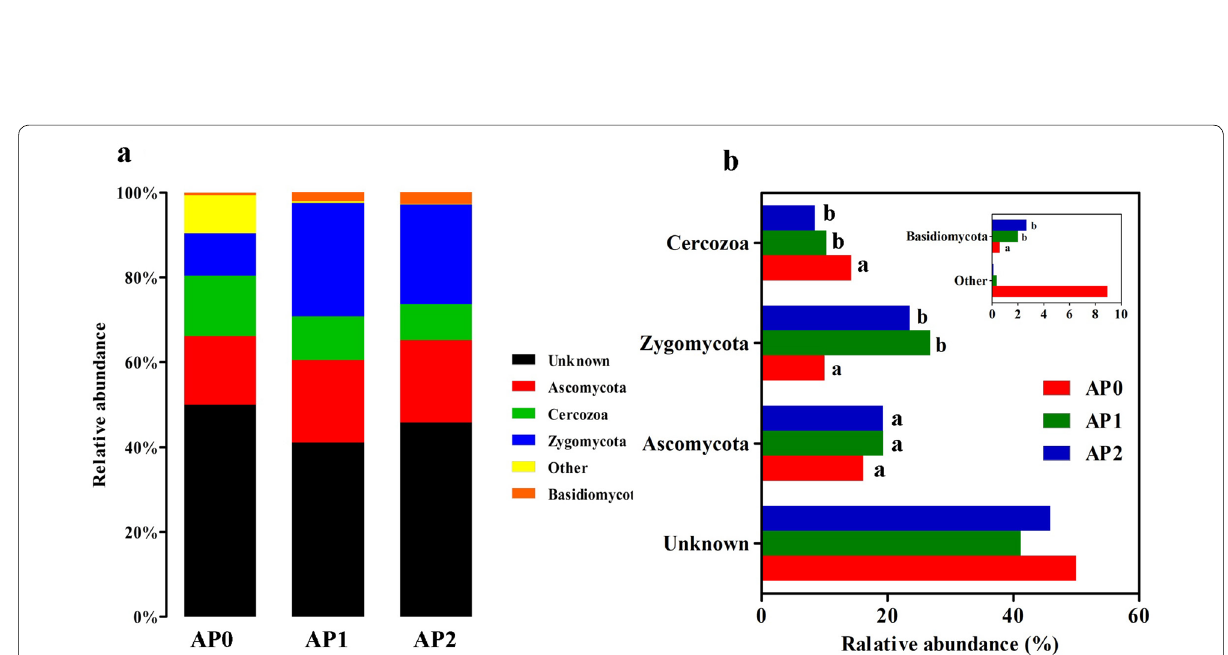
Fig. 6 Relative abundance of the dominant fungal phyla in the soils continuously cropped Andrographis paniculata. a Fungal community composition at the phylum level. b Variations of fungal community composition. Only phyla with more than 1% relative abundance in at least one sample were shown and different letters mark significant difference at P < 0.05. The “Other” group contained the phyla with relative abundance < 1%. AP0, AP1 and AP2 represent soils with continuously cropping histories of A. paniculata for 0, 1 and 2